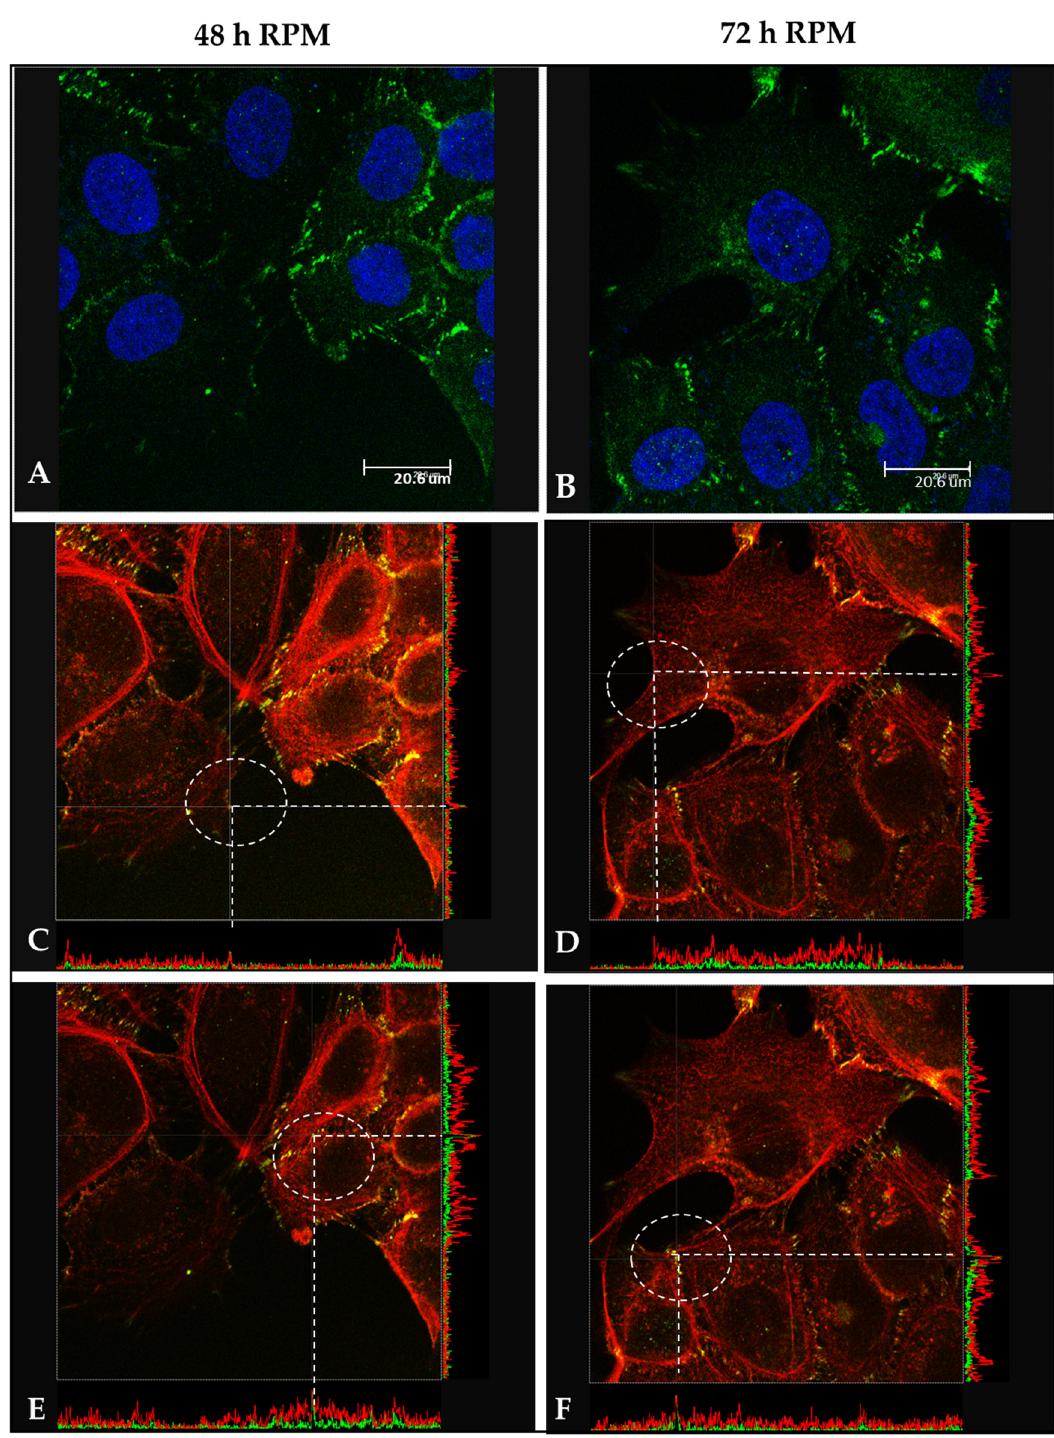
Figure 5. Representative images of colocalization analysis of vinculin (green) and F-actin (red) in HaCaT cells cultured in RPM for 48 and 72 h. In A, B vinculin distribution is shown; vinculin distribution is appreciably reduced at the cell periphery, while it is increased at the cell–cell contact both at 48 h ( A ) and 72 h ( B ). ( C – F ) show colocalization analysis of F-actin and vinculin. In the X/Y axes, at the level of the dotted lines, the colocalization (green and red picks) is shown. Colocalization after 48 h is still evident in some parts of the cellular periphery (( C ), dotted circle), albeit reduced compared to RPM at 24 h, and it appears in cell–cell contacts (( E ), dotted circle). Contrarily, at 72 h, no colocalization is observed at the level of periphery (( D ), dotted circle), while being recognizable in cell–cell contact areas (( F ), dotted circles). Scale bars 20.6 µm.